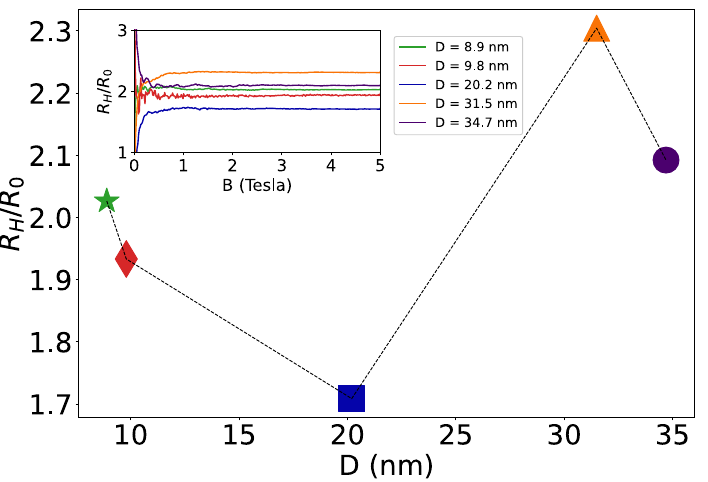
Figure 7. The normalized Hall constant of the samples measured at 5 K plotted as a function of the average grain diameter D , computed from R H = ρµ H . In the inset we plot the magnetic field dependence of the normalized Hall constant measured at 5 K, computed from R H = R 0